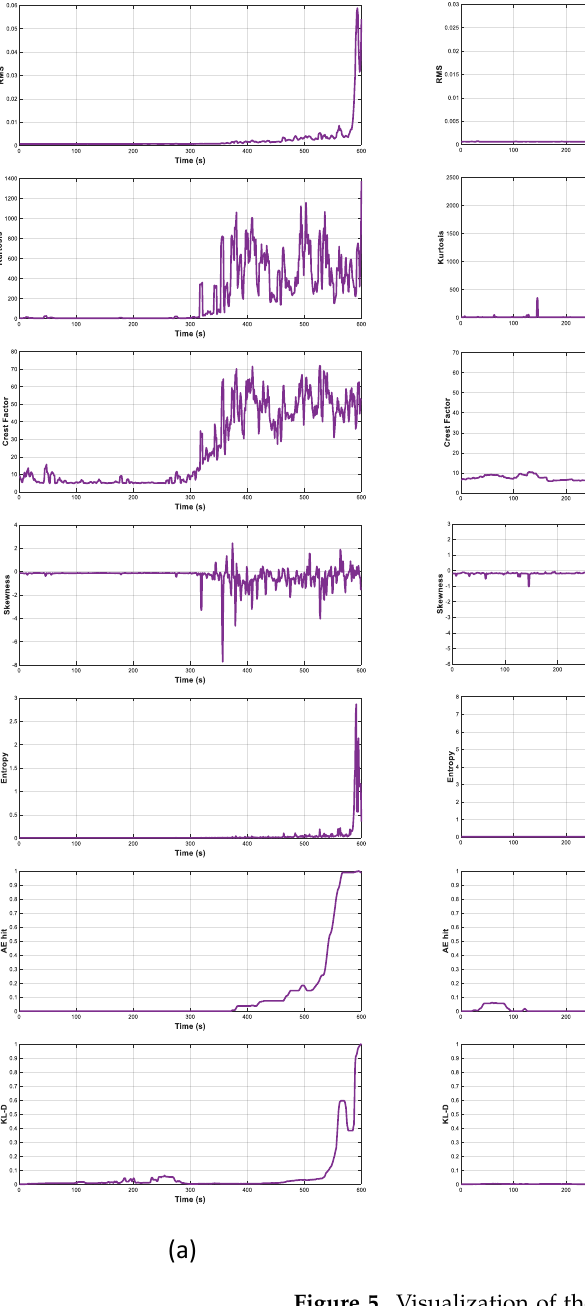
Figure 5. Visualization of the proposed and other HI-constructing factors (RMS, Kurtosis, Crest Factor, Skewness, and AE hit) from sensor 5 of reinforced concrete beam: ( a ) α , ( b ) β , and ( c ) γ.